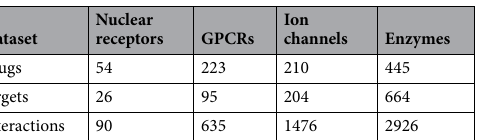
Table 3. Datasets from human nuclear receptors, GPCRs, ion channels and enzymes 17 .